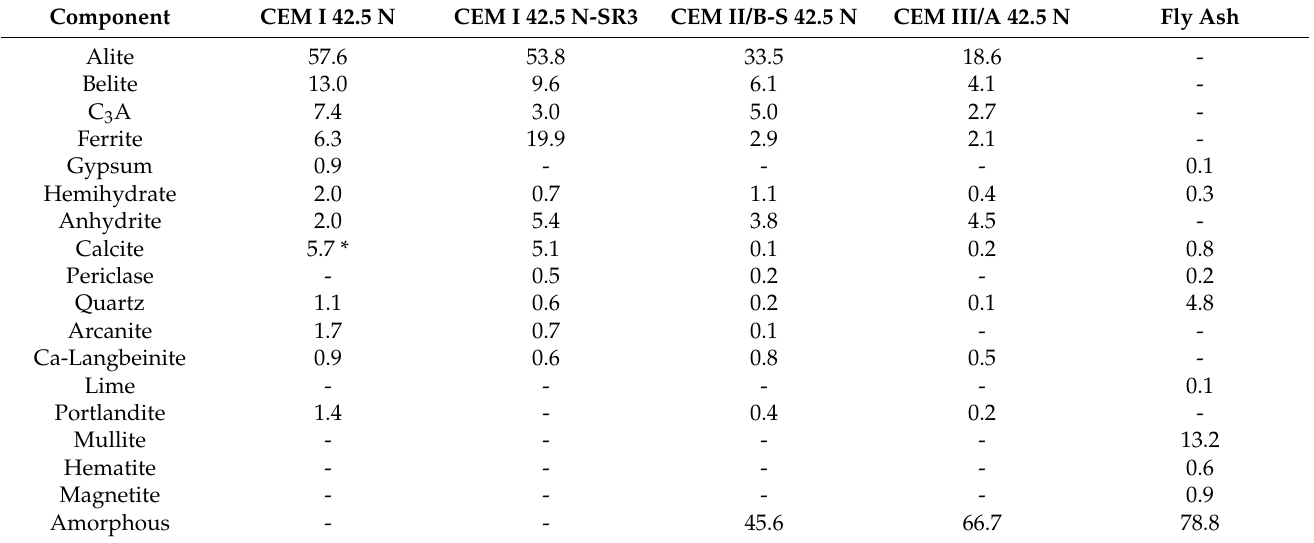
Table 2. Mineralogical composition of the cements and the fly ash.